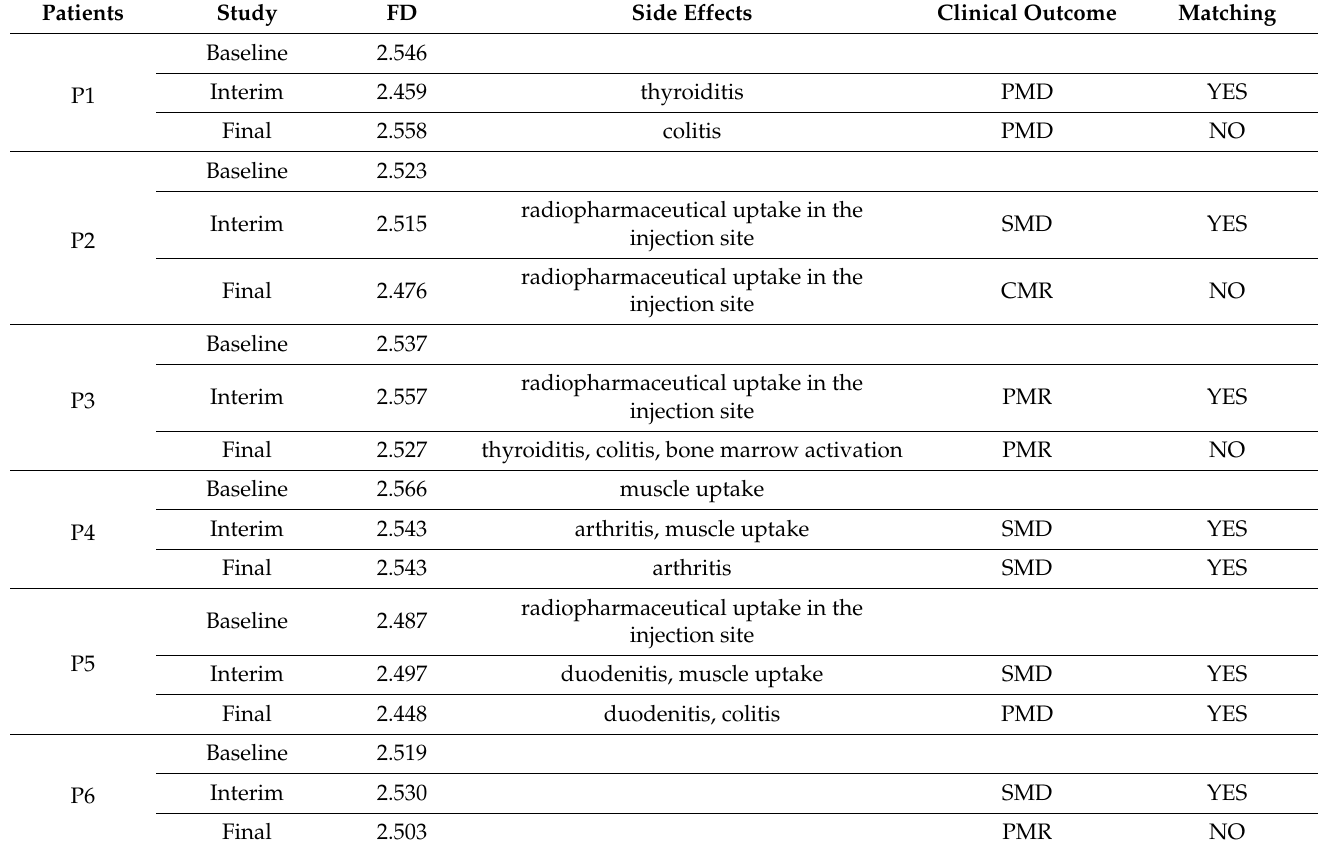
Table 2. Presentation of patient and control Fractal Dimensions